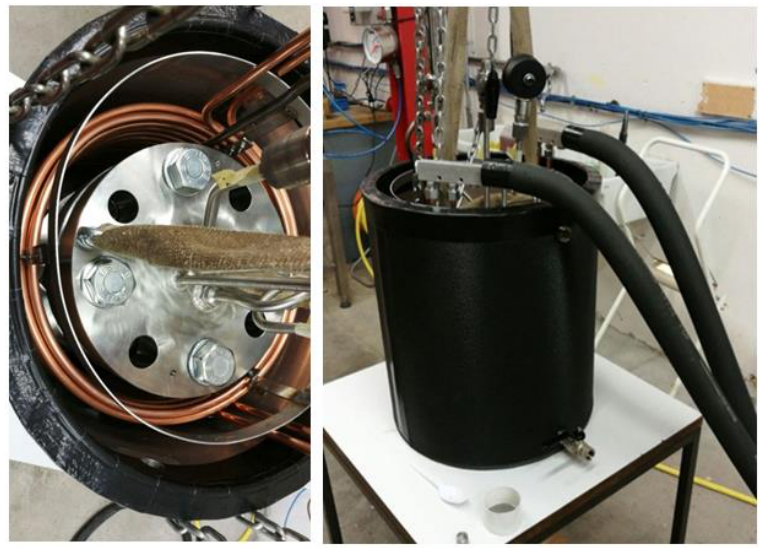
Figure 2. Experimental apparatus: view from above on the left, side view on the right.